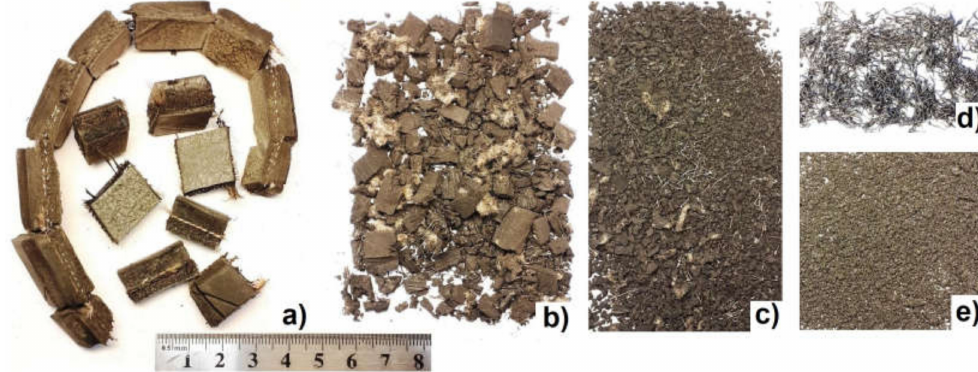
Figure 6. Grinding at ambient temperature using the SD-25 grinder. ( a ) Initial pieces; ( b ) Pre-crushed; ( c ) Milled tire; ( d ) Separated wire; and ( e )